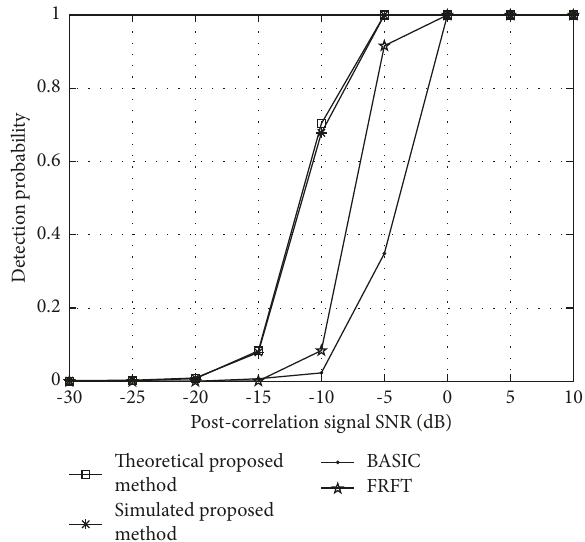
Figure 4: Detection probabilities comparison when is 200ms, chirping rate is 200Hz/s, and initial frequency is